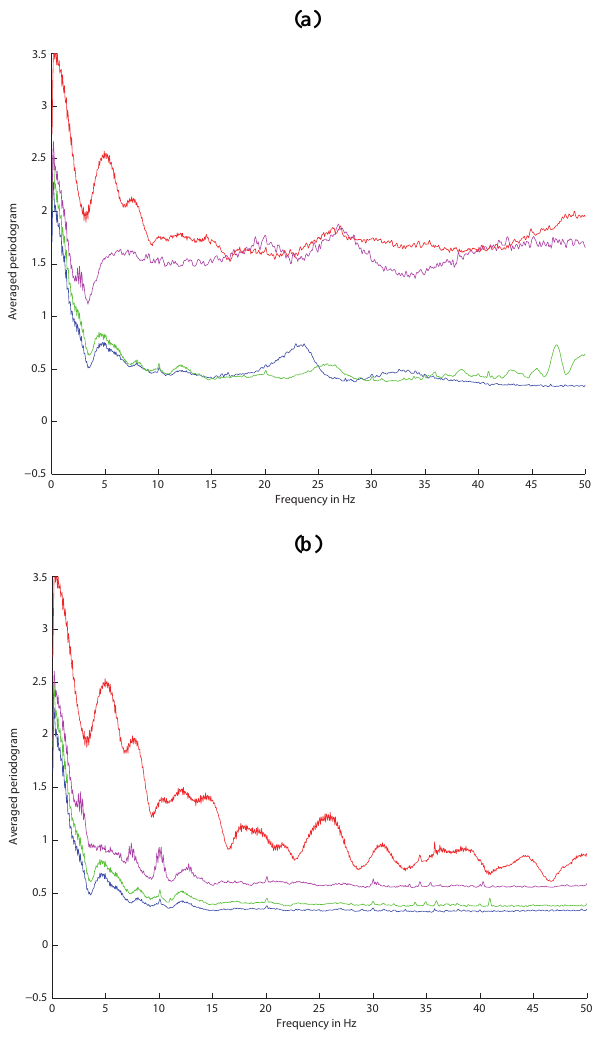
Fig. 4. Averaged seismic noise amplitude as a function of fre- quency, for various time periods, from 11 October: (1–50h: blue; 320–360h: green; 600–630h: magenta; 700–728h : red) ; (a) sta- ble massif, S2 seismometer; (b) unstable rock slice, S3 seismome- ter.